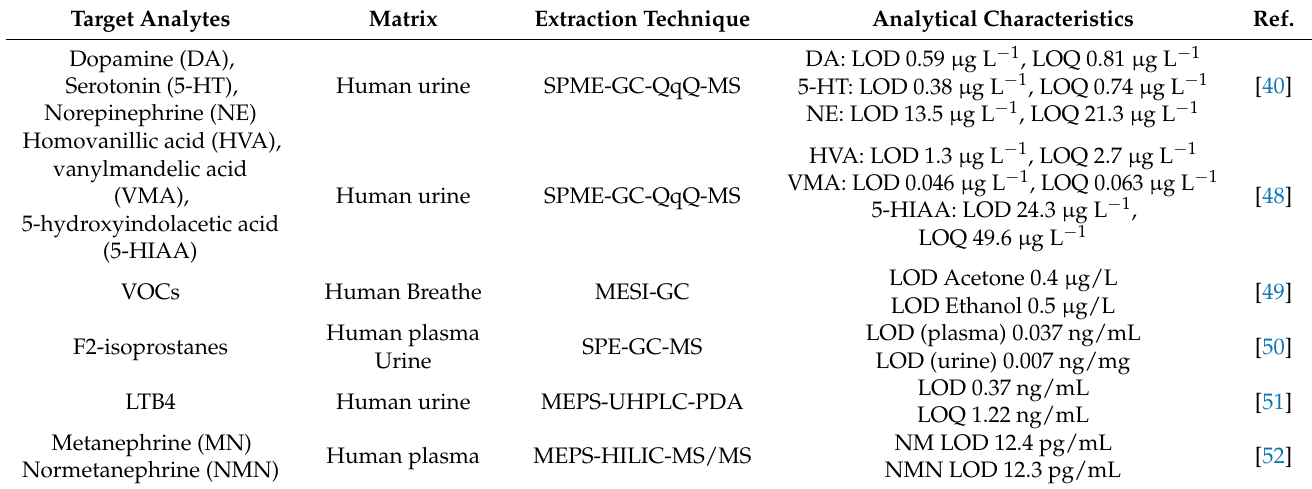
Table 2. Microextraction techniques used for diagnostic purposes.